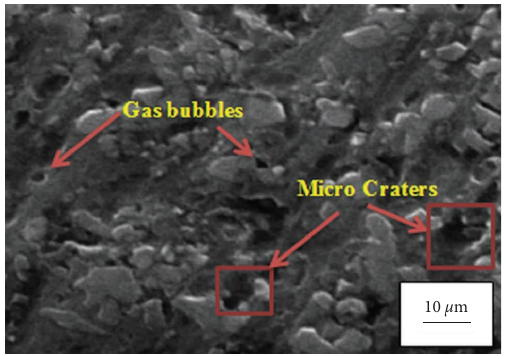
Figure 12: SEM image of experiment no. 8 (combined parameters of FE2-VO4-EL3-ED2).